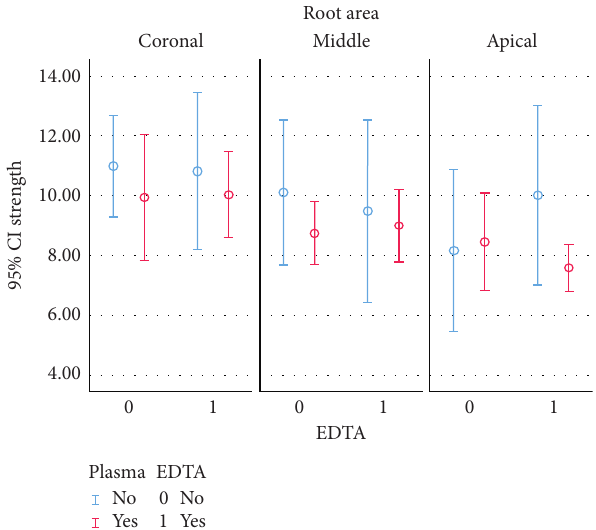
Figure 1: Bond strength in different parts of the root based on the type of surface treatment. Table 1: Frequency distribution of the modes of failure in different parts of the root.